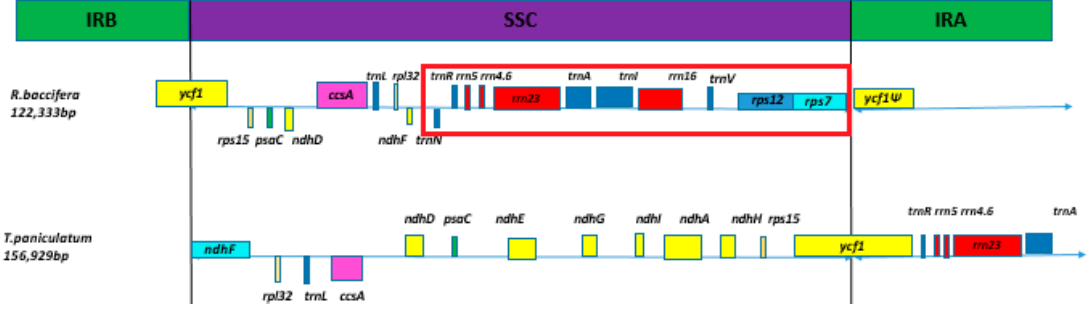
Figure 4. Structural comparison of the SSC region of R. baccifera to Talinum paniculatum , displaying the SSC inversion in R. baccifera . A display of the SSC inversion in R. baccifera.